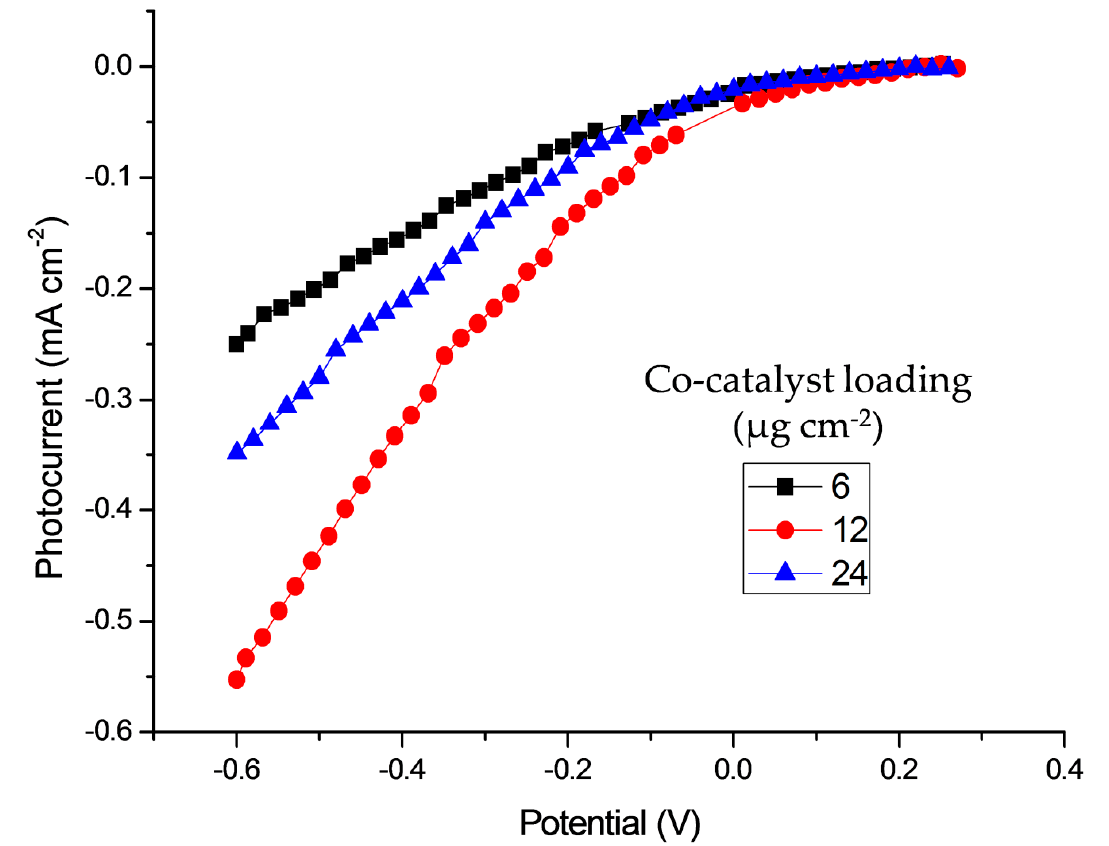
Figure 4. Photocurrent vs. voltage for 3 PECs containing different amounts of the NiFeOx co-catalyst at the anode (6, 12, 24 µg cm − 2 ).